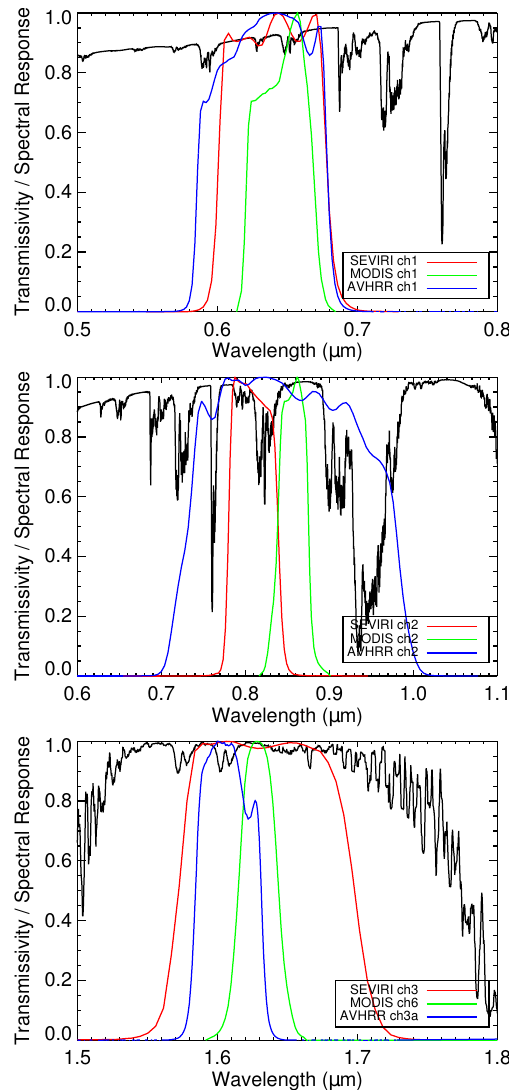
Fig. 1. Spectral response functions of SEVIRI, MODIS and AVHRR for the three solar channels considered in this paper, as obtained from http://www.eumetsat.int/Home/Main/ Satellites/MeteosatSecondGeneration/Instruments/index.htm, ftp:// mcst.hbsss-sigma.com/pub/permanent/MCST, and http://www2. ncdc.noaa.gov/docs/klm/html/d/app-d.htm, respectively. A nadir transmissivity spectrum calculated with MODTRAN and based on a tropical atmosphere (McClatchey et al., 1971) is shown in